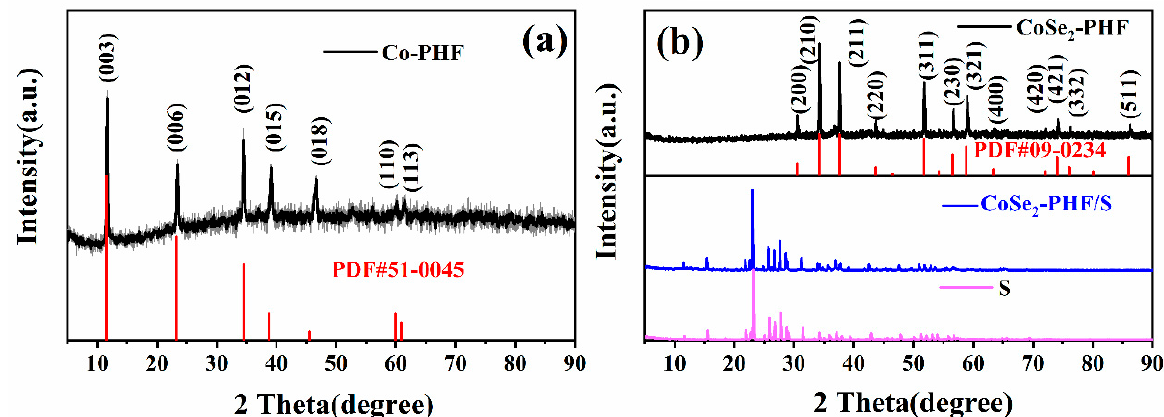
Figure 4. XRD patterns of ( a ) Co-PHF, and ( b ) CoSe 2 -PHF & CoSe 2 -PHF/S. Cyclic voltammetry (CV) was conducted to investigate the catalytic activity of CoSe 2 -PHF toward the conversion of LiPSs in the charge-discharge process. As shown in Figure 5a, two reduction peaks (R 1 and R 2 ) and one oxidation peak (O) were observed in both CoSe 2 -PHF/S and CoSe 2 /S electrodes. For CoSe 2 /S-based electrode, the first reduction peak (R 1 ) corresponded to the conversion of sulfur (S 8 ) to long-chain Li 2 S n (4 ≤ n ≤ 8), and the second reduction peak (R 2 ) was related to the further reduction of long-chain LiPSs to short-chain Li 2 S 2 and LiS 2 , as well as CoSe 2 -PHF/S based electrode [44–46]. The broad oxidation peak centered at about 2.455 V represented the two continuous oxidation processes. As shown in Figure 5b and Figure S2 (see Supplementary Materials), both reduction and oxidation peaks were highly dependent on the potential scan rate. As the potential scan rate increased, two reduction peaks shifted to lower potential while the oxidation peak shifted to higher potential. Significantly, the area ratio of reduction peak to oxidation peak for CoSe 2 ‐ PHF/S electrode was close to 1, indicating its highly reversible reaction of sulfur redox. By contrast, the two reduction peaks of CoSe 2 /S ‐ based electrode centered at lower potential (2.238 V, and 2.027 V, respectively), and the oxidation peak centered at a higher potential (2.487 V), which suggested that CoSe 2 ‐ PHF possessed higher catalytic activity than CoSe 2 . And CV tests on the symmetrical cells of CoSe 2 ‐ PHF electrode and CoSe 2 electrode (without loading sulfur) showed the same conclusion. As shown in Figure 5c, the redox current in CoSe 2 ‐ PHF cell increased faster than that of CoSe 2 ‐ based cell with the increasing of potential, implying that CoSe 2 ‐ PHF electrode can really accelerate the conversion of LiPSs and enhance the kinetics of electrode reaction.